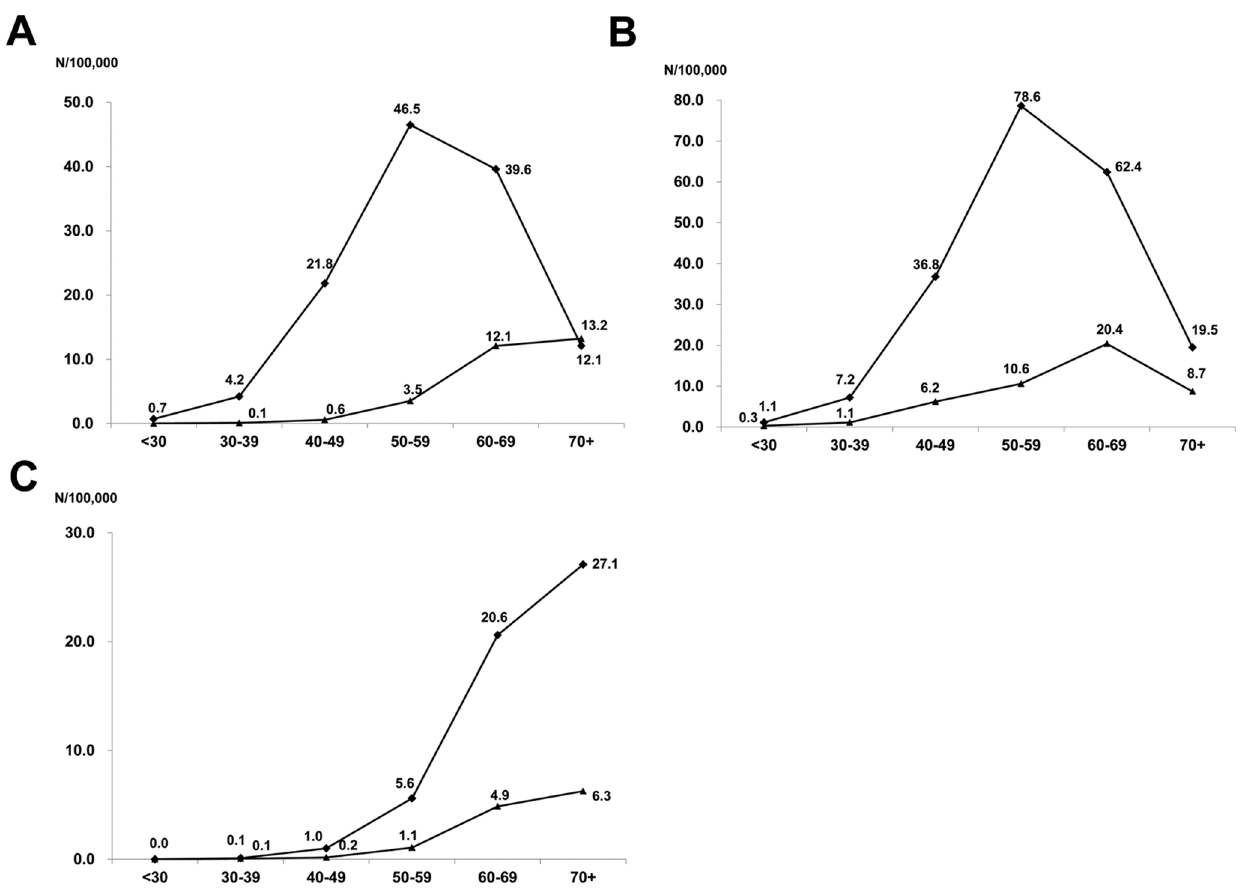
Figure 1. The age-specific incidence rates of hepatocellular carcinoma (HCC) by the etiology (A), by gender in HBV-related HCC (B) and by gender in HCV-related HCC (C). The annual incidence rates of HBV-related HCC peaked in the 50–59 age group, while the annual incidence rates of HCV-related HCC kept gradually increasing until age $ 70 s. Similar trend was observed after stratified by gender, although the peak mean annual incidence rates was observed in the 50–59 in men and in the 60–69 in women in HBV-related HCC (B). Diamonds ( ¤ ) and triangles ( m ) represent for HBV and HCV-related HCC in (A), men and women in (B) and (C), respectively.